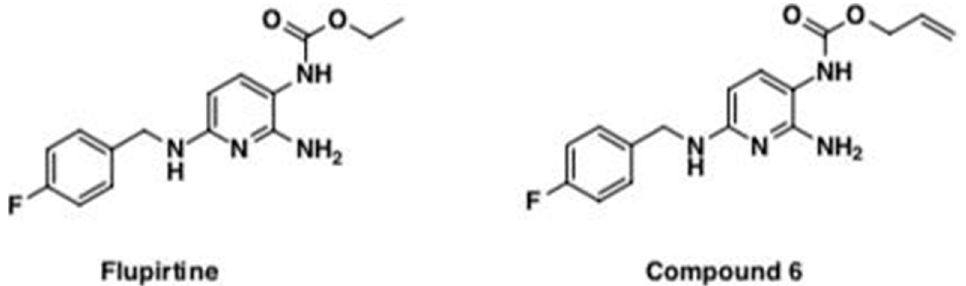
Figure 1. Chemical structure of flupirtine and its allyl carbamate derivative, compound 6.